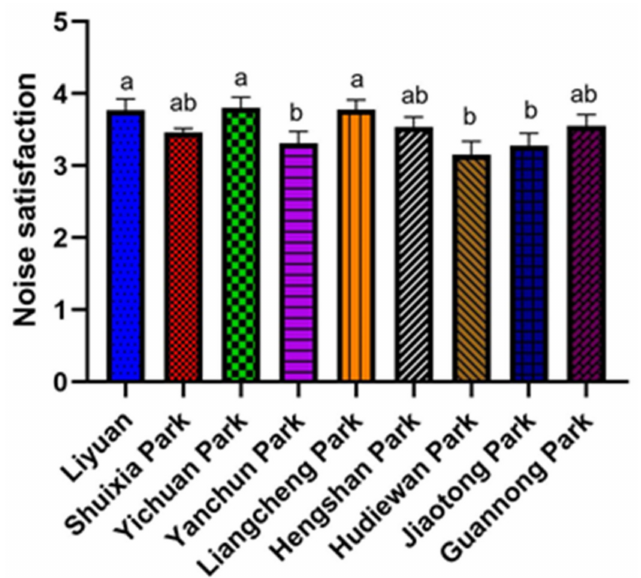
Figure 2. Differences in noise satisfaction among nine SUGS. Different letters indicate the difference between groups is significant at 0.05